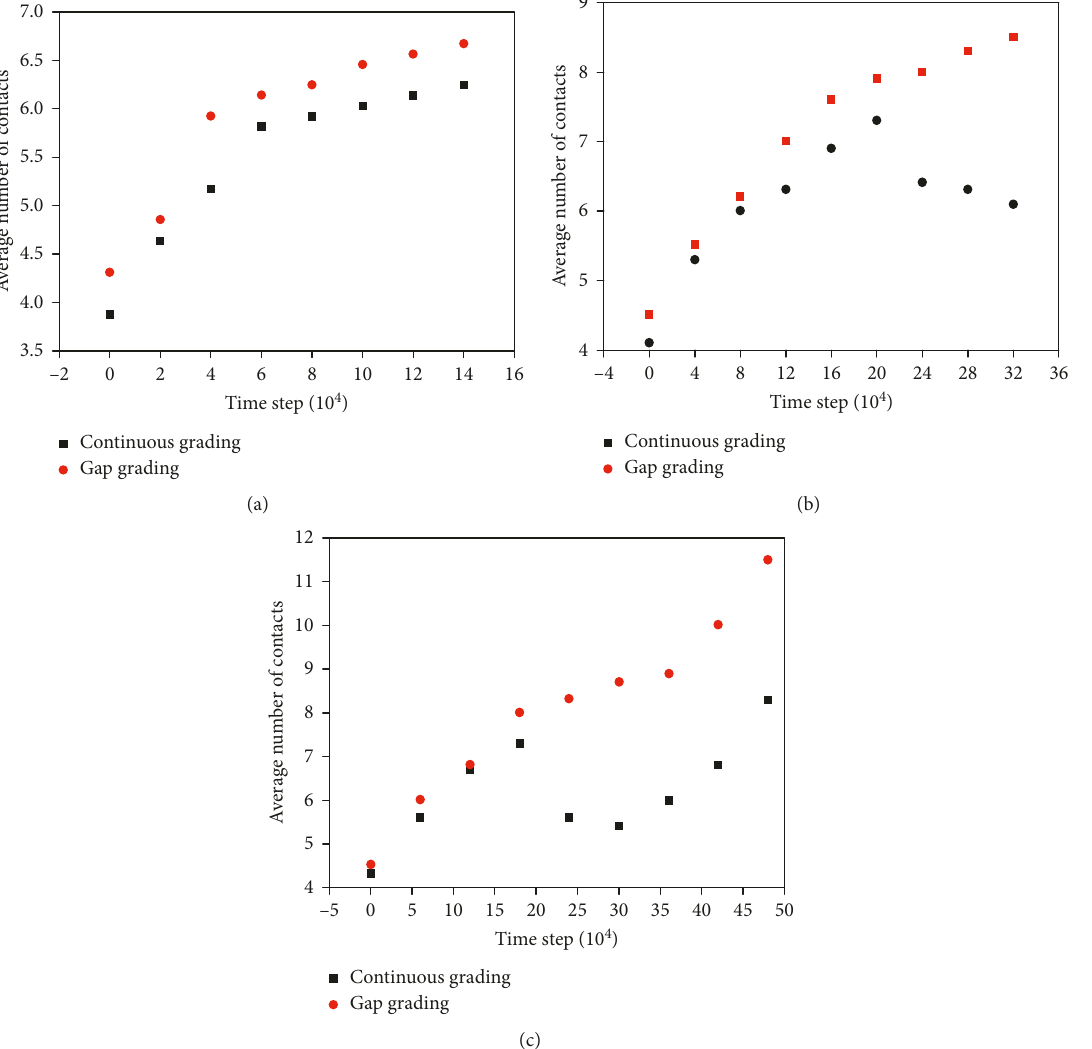
Figure 22: Variation of the average coordination numbers with different penetration displacements: (a) S � 6mm, (b) S � 12mm, and (c) S �